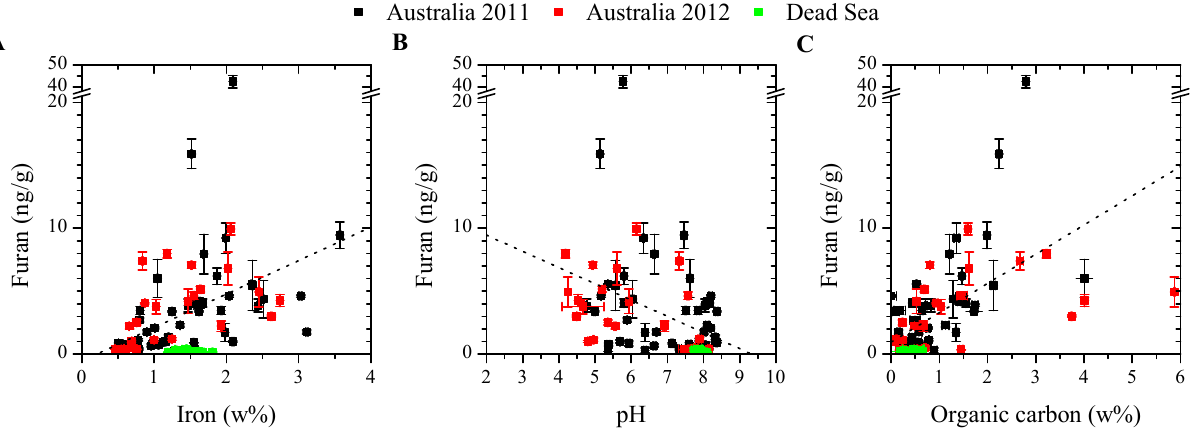
Figure 5. Furan emissions dependent on (A) iron concentration, (B) pH and (C) organic carbon content of the sediments (Australia 2011: black; Australia 2012: red; Dead Sea 2012: blue). Data points represent mean values with error bars indicating standard deviations from triplicate